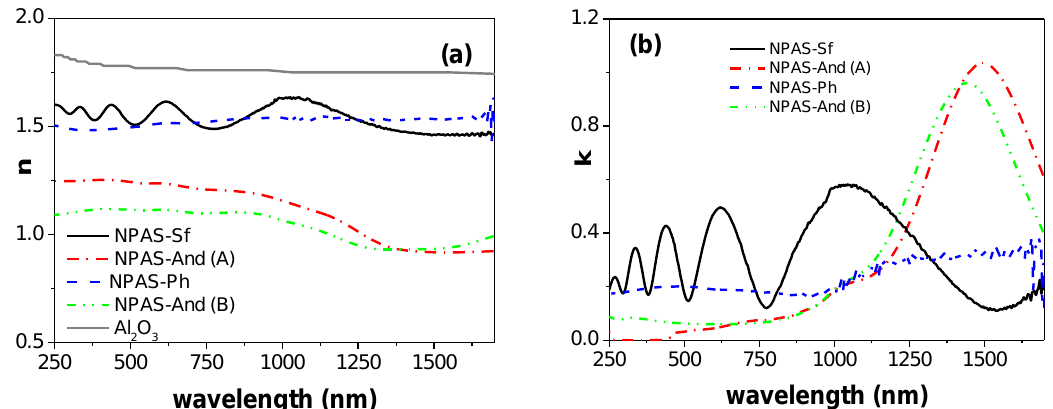
Figure 4. Wavelength dependence of ( a ) refraction index and ( b ) extinction coefficient values for samples: NPAS-Sf (black dense line), NPAS-Ph (red dashed line), NPAS-And surface A (blue dashed-dotted line), and NPAS-And surface B (green dashed-dotted-dotted line). For comparison reasons the refraction index of pure Al 2 O 3 is indicated in ( a ) as a grey dense line.